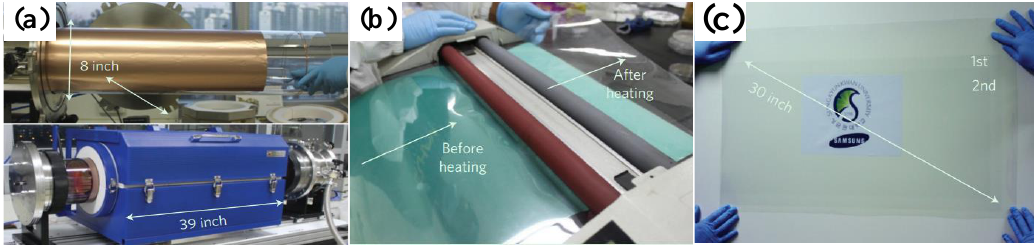
Figure 10. Synthesized progress when introducing roll-to-roll technology into CVD. ( a ) CVD; ( b ) Roll-to-toll technology; ( c ) Graphene with 30-inch. (Reproduced from [36] with permission; Copyright 2010 Nature.)